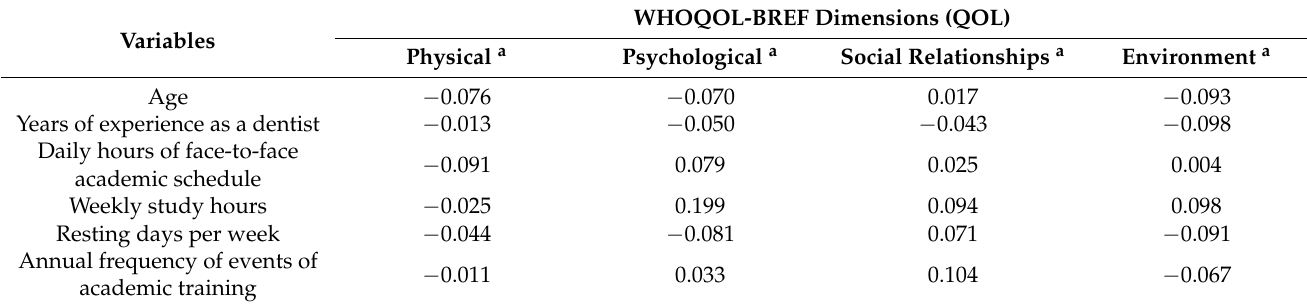
Table 1. Bivariate correlations between the WHOQOL-BREF dimensions of QOL and the quantitative variables in the study sample ( n =